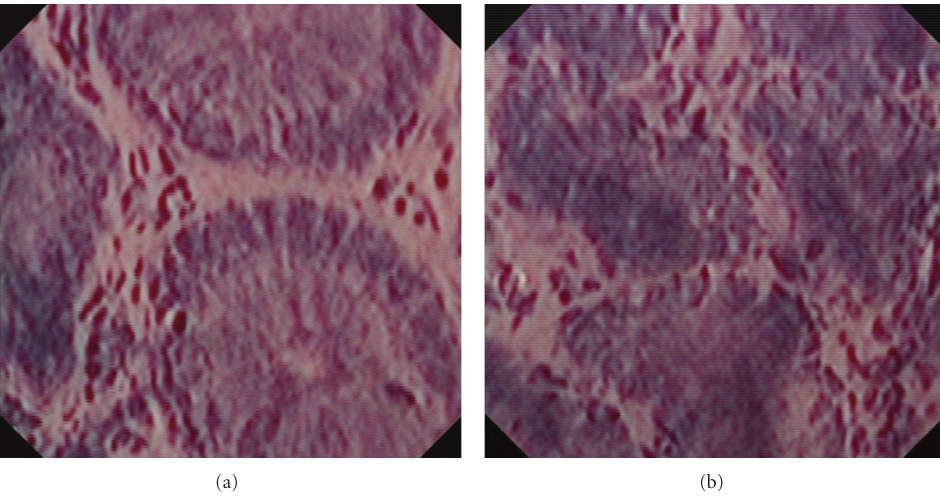
Figure 6: Endocytoscopy with 1390-fold magnification in quiescent (a) and active (b) Crohn’s disease. Endocytoscopy enables clear visualization of di ff erent cellular structures within the intestinal mucosa, including the size, arrangement, and density of